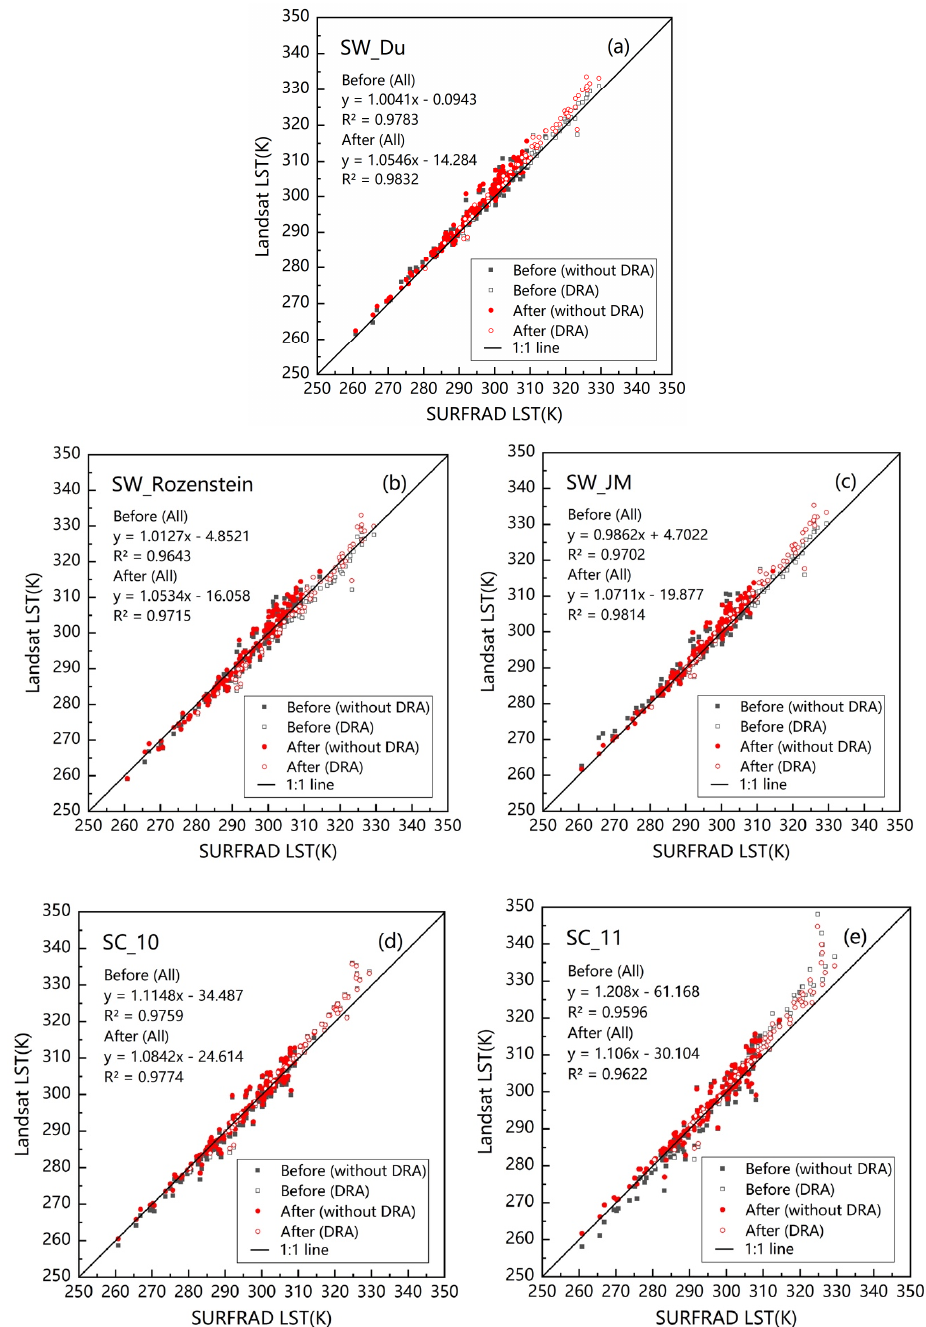
Figure 4. Comparison of retrieved LST before and after the stray light correction for different algorithms. ( a ) for SW_Du, ( b ) for SW_Rozenstein, ( c ) for SW_JM, ( d ) for SC_10, and ( e ) for SC_11. The linear regression coefficients were obtained from data of all five sites. “Before/After (without DRA)” in the figure means the data from the other four SURFRAD sites after excluding DRA before or after the correction; “Before/After (DRA)” in the figure means the data from the DRA site before or after the correction.